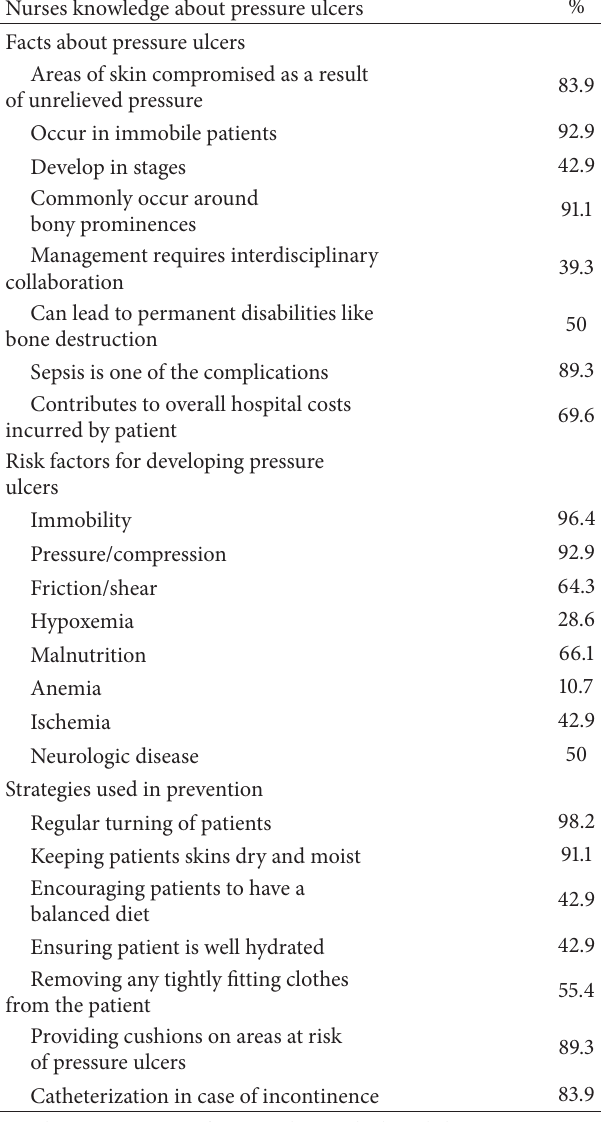
Table 2: Nurses knowledge about pressure ulcers. Table 3: Nurses’ daily activities when caring for a patient at risk of developing pressure